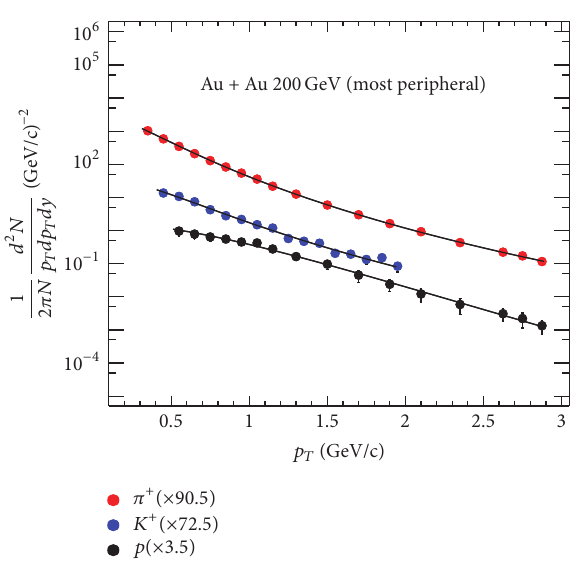
Figure 15: Fitting of invariant 𝑝 𝑇 spectra with Tsallis distribution including chemical potential using(6)for 𝜋 + [18], 𝐾 + [18],and 𝑝 [18] in most peripheral Au + Au collisions at √𝑠 NN = 200 GeV. Symbols represent the data points and the line is the fit